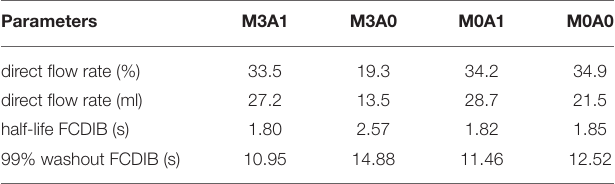
TABLE 4 | Intraventricular washout measures of the four representative